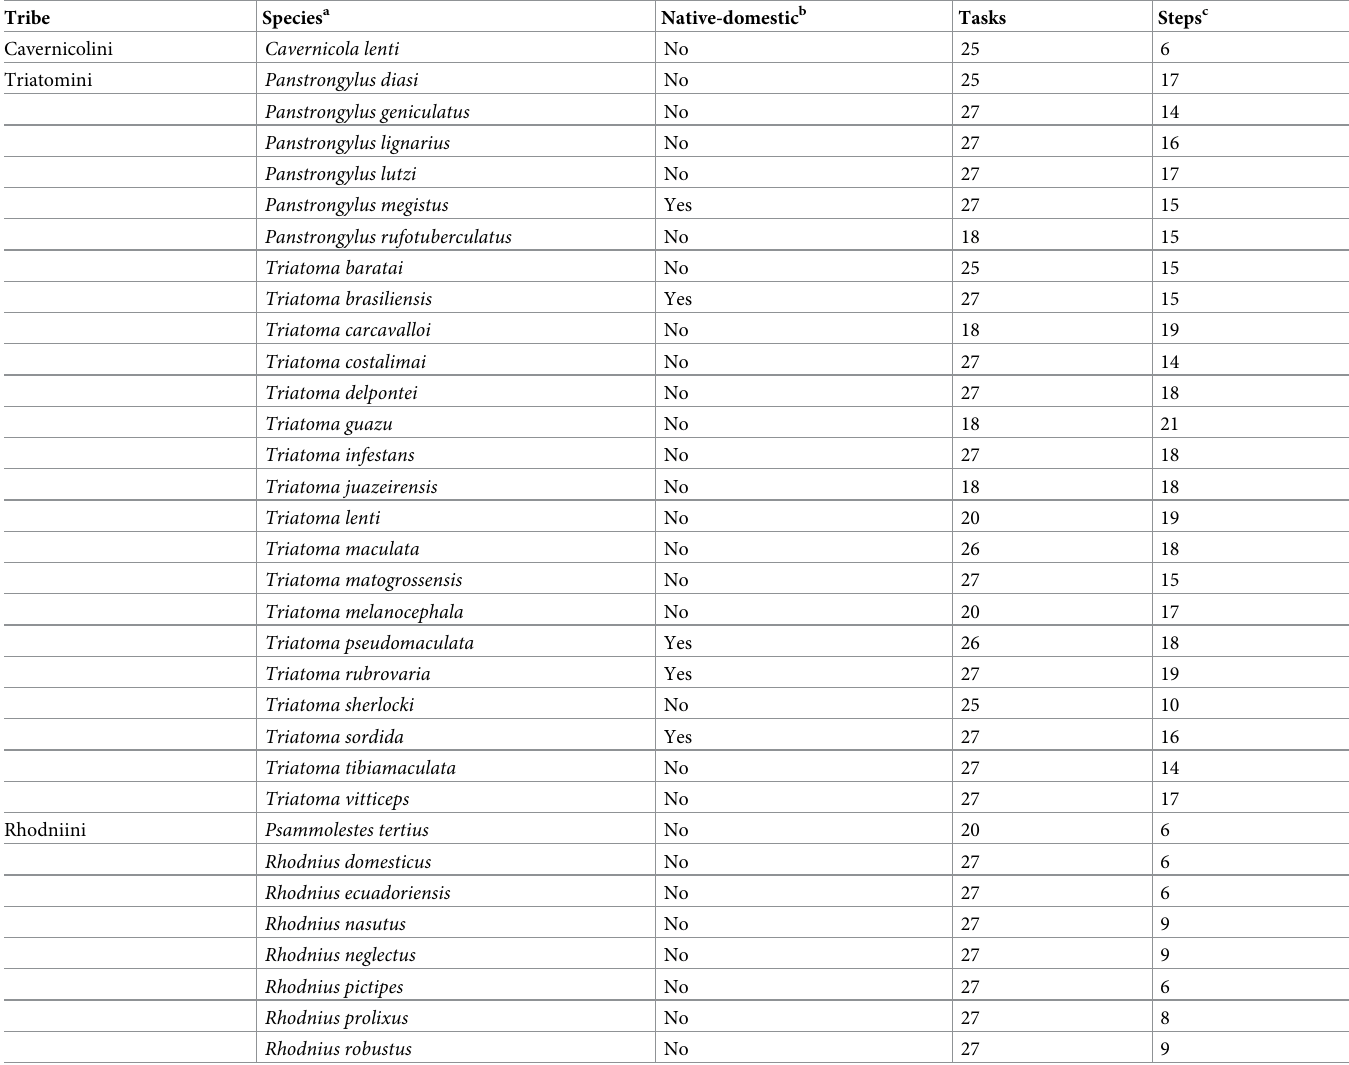
assignments as ‘correct’ (right species-level identification; coded ‘1’) or ‘incorrect’ (wrong identification or failure to reach species-level identification; both coded ‘0’). We were primarily interested on overall T RIATO D EX performance, measured as the propor- tion of correct identifications. In addition, we aimed at testing some focal hypotheses (summa- rized in Table 3) about possible sources of variation in T RIATO D EX performance across selected user and target-species traits. We first computed descriptive statistics based on counts and pro- portions (with score 95% confidence intervals [CI]). We then used bivariate generalized linear mixed models (GLMMs; [40]) with binomial error distribution and logit link-function to